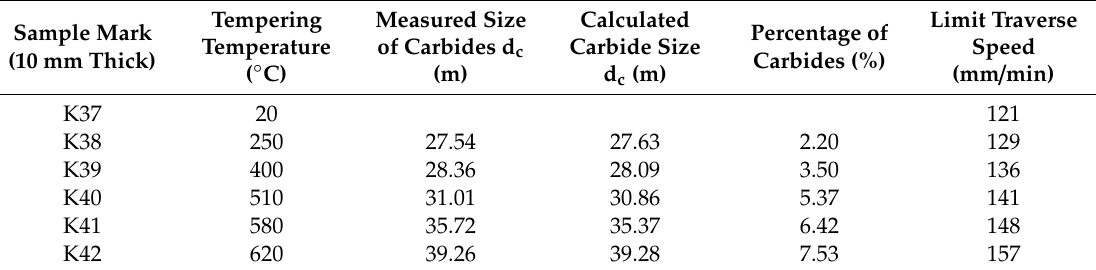
Table 5. Tempering temperatures of the 34CrMo4 steel, respective experimental carbide sizes, carbide sizes calculated from experimentally based Equation (7), volume percentage of carbides and the limit traverse speeds set for the cutting machine in